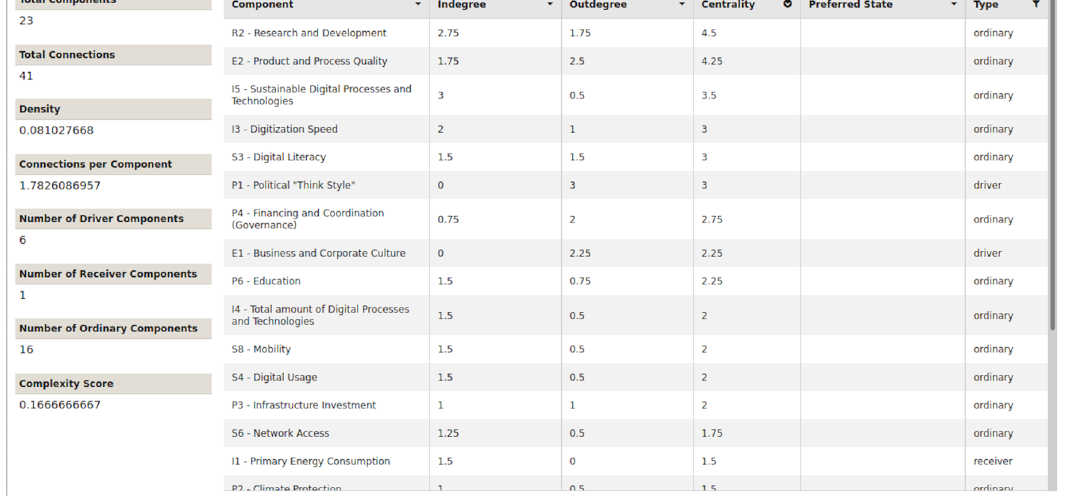
Figure 11. Innovative and sustainable COVID-19 scenario. Network parameters and centrality (Screenshot from Mental Modeler Software).